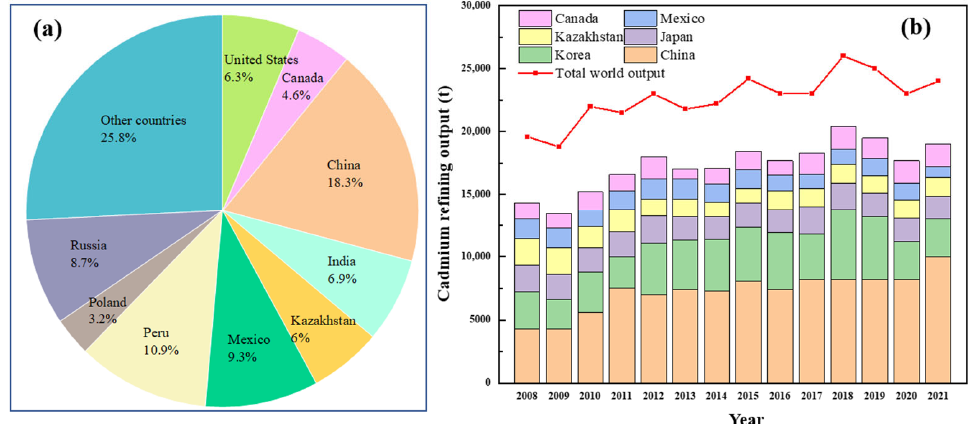
Figure 2. ( a ) Cd resource reserves in the world; ( b ) global refined Cd production.